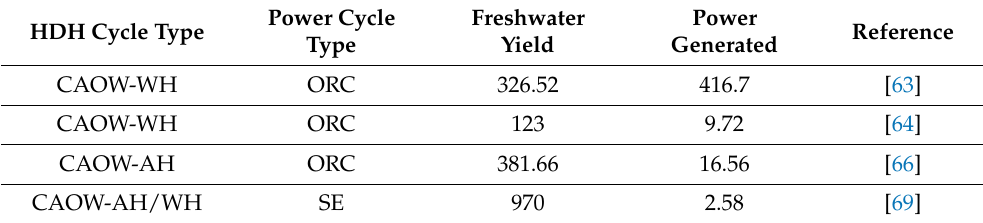
Table 3. Summary of performance of various HDH–PWR